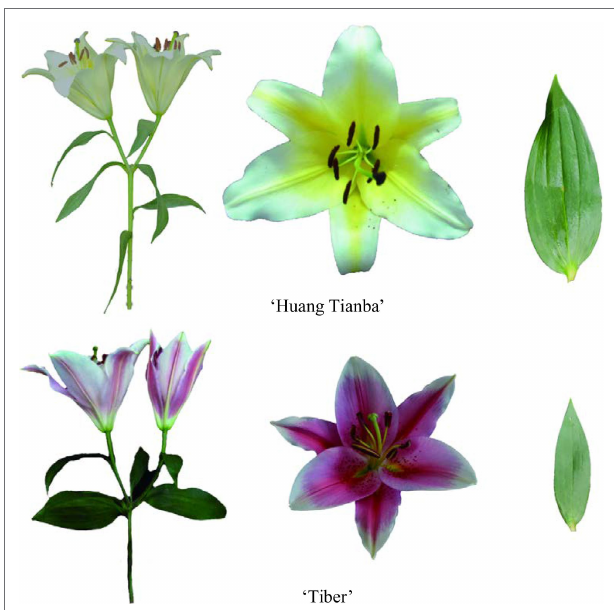
FIGURE 1 | Lilium spp. (lily) flowers of the cultivars ‘Huang Tianba’ and ‘Tiber’. The cut flowers comprise open tepals, leaves, and